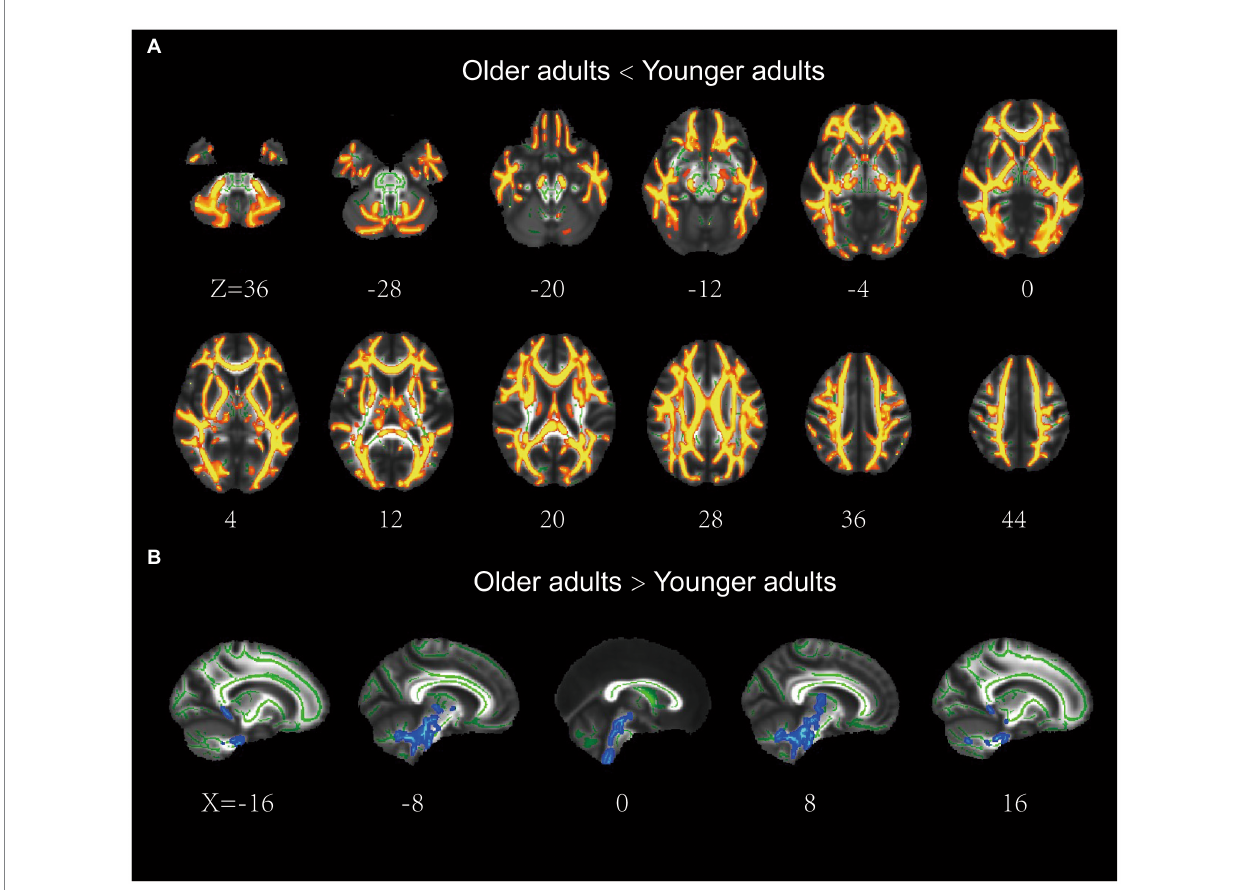
FIGURE 2 Results of the tract-based spatial statistics of fractional anisotropy between the older and younger adults. (A) the older adults showed lower FA than the younger adults in a large portion of the WM skeleton, including IFOF, ILF, SLF, ATR, CCG, Fmaj, and Fmin. (B) the older adults showed higher FA than the younger adults in a small fraction of voxels (e.g., brainstem). IFOF, inferior frontal-occipital fasciculus; ILF, inferior longitudinal fasciculus; ATR, anterior thalamic radiation; SLF, superior longitudinal fasciculus; CCG, cingulum cingulate gyrus.